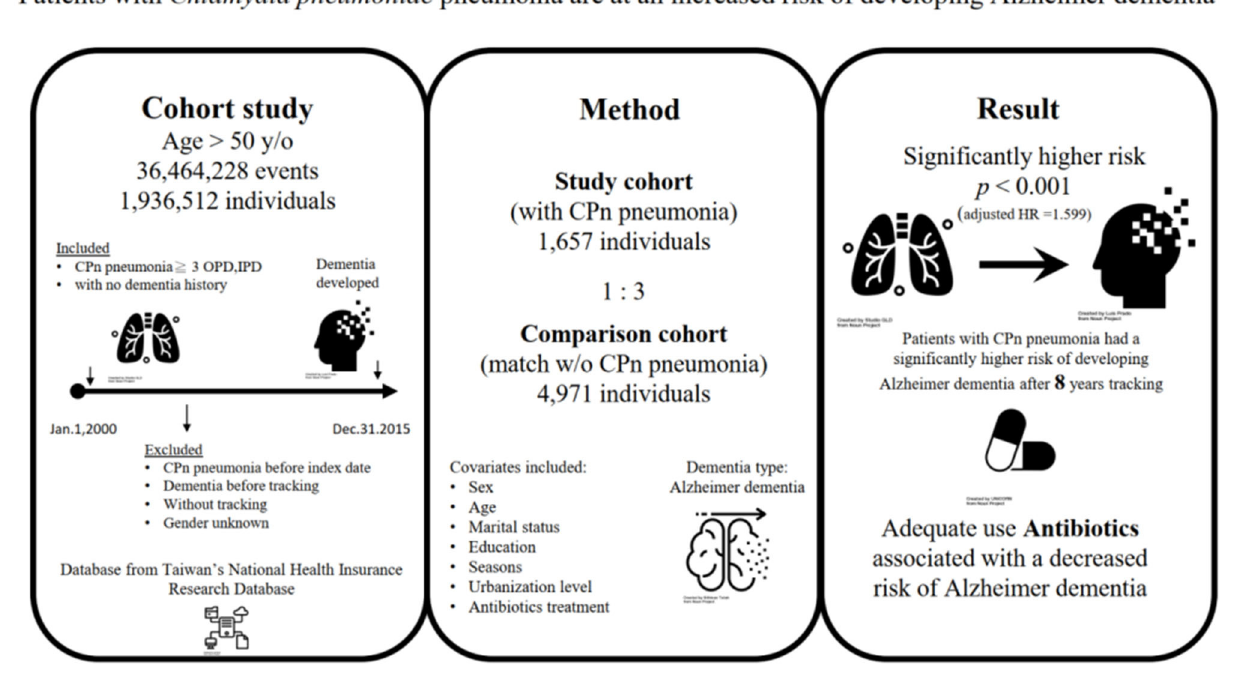
FIGURE 1 | The graphic abstract of study design and results from National Health Insurance Research Database in Taiwan. CPn, Chlamydia pneumoniae ; OPD, outpatient clinic; IPD, Inpatient departments; HR, Hazard Ratio. All icons are from the Noun